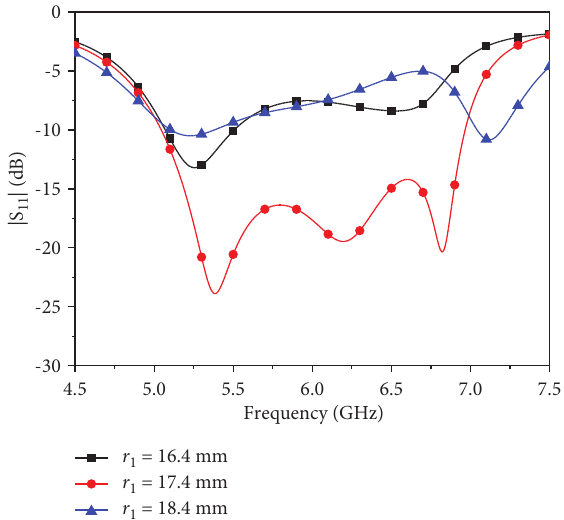
Figure 4: | S 11 | of the proposed antenna for different r 1.